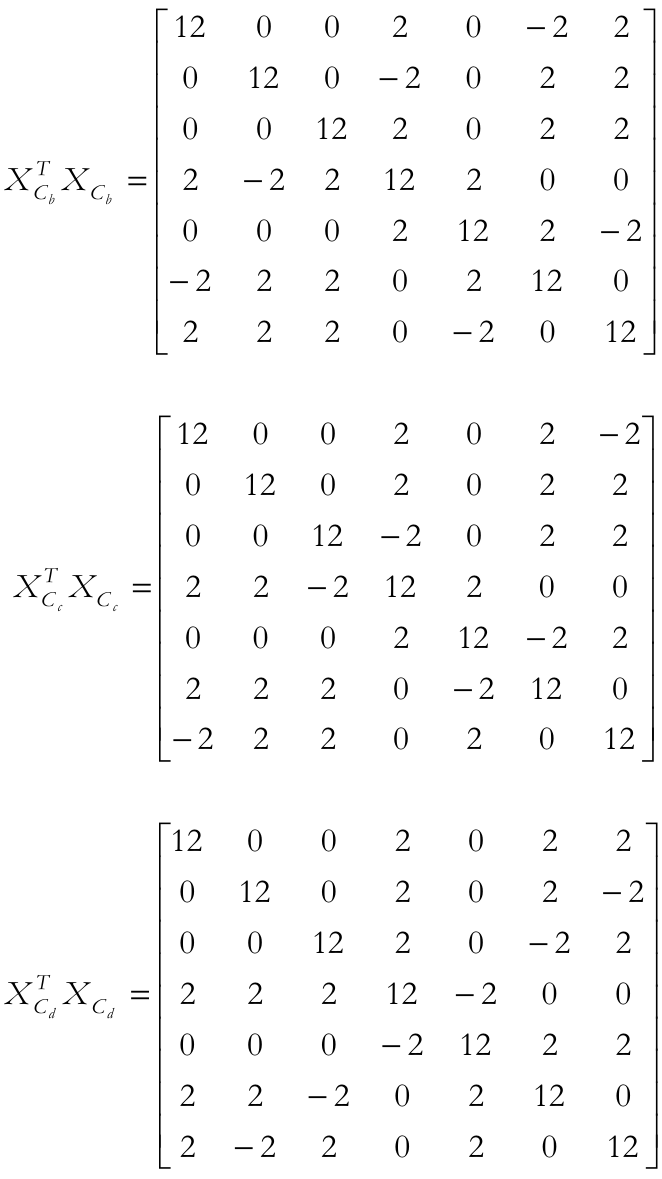
6.2. Disegni con N = 12 osservazioni, k = 4 fattori principali e risoluzione R = V I disegni D -ottimali con N = 12 osservazioni e k = 4 fattori principali sono ot- tenuti aggiungendo a ciascuno dei disegni non equivalenti con N = 12 osserva- zioni e k = 3 fattori principali, una nuova colonna di elementi ±1. Dati i primi tre fattori A , B e C , si riportano nella seguente tabella le colonne C C , C che costituiscono le combinazioni di elementi ±1 in corrispondenza del g h quarto fattore principale D in tutti i possibili disegni ottimali non equivalenti con k = 4 fattori